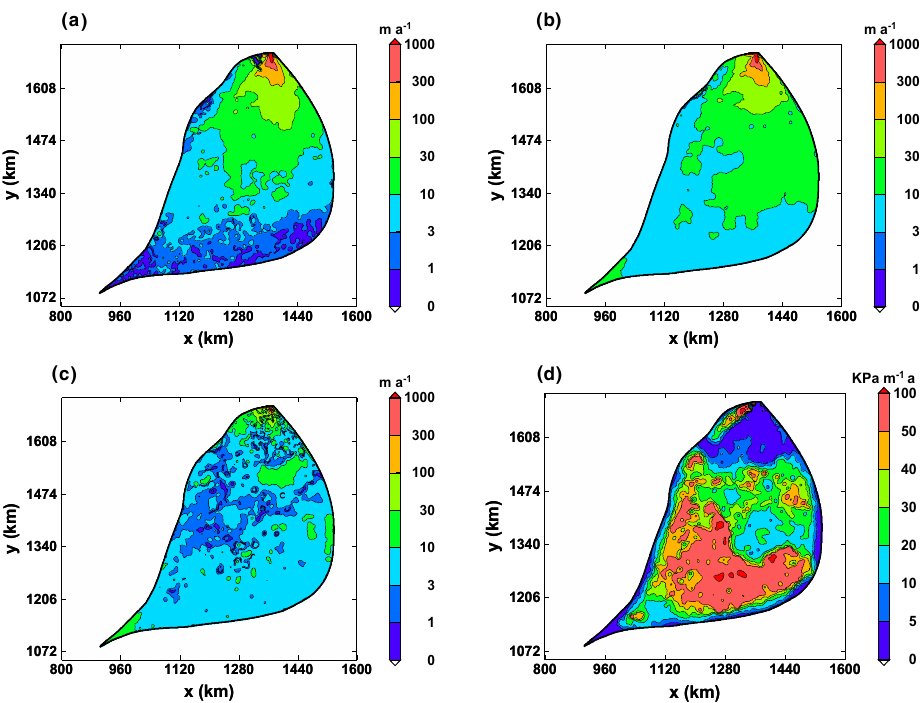
Figure 3. (a) Observed InSAR-based ice surface velocities (Rignot et al., 2011), (b) surface velocities computed using FS and the control inverse method, (c) absolute error of the surface velocities | v h − v obs coefficient β